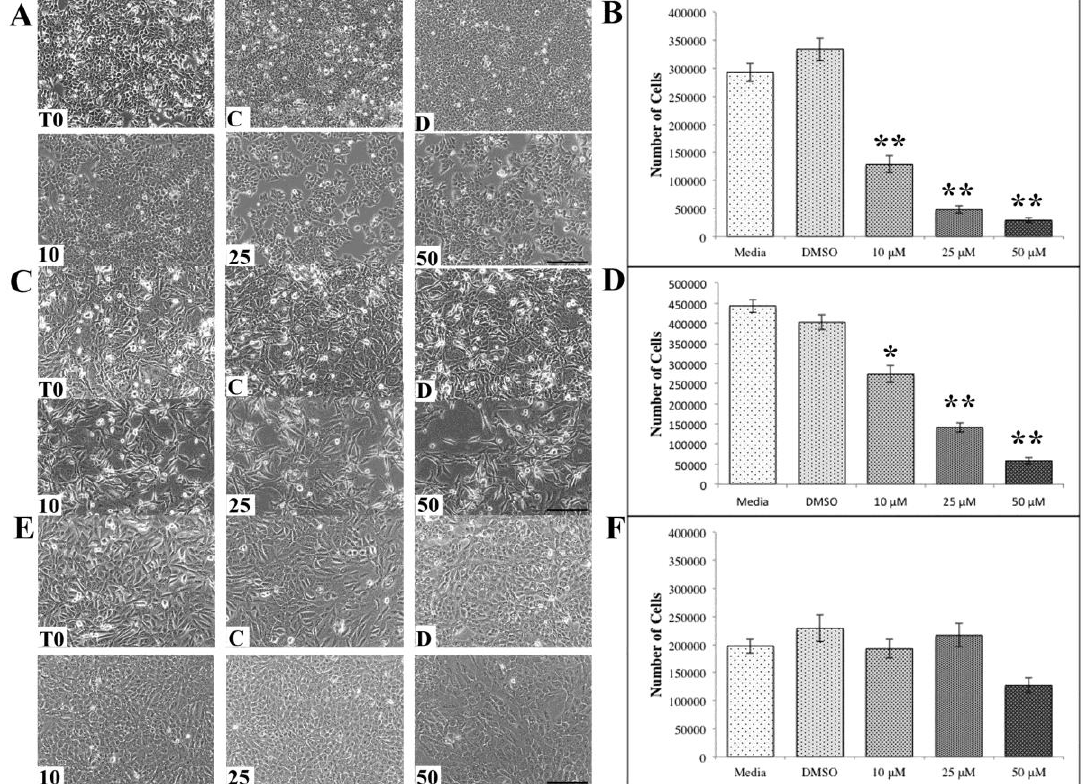
Figure 3. Astaxanthin (ASX) affects cell numbers. ( A ) MCF7 cells treated with ASX at concentrations indicated for 24 h; ( B ) quantification of ( A ); ( C ) MDA-MB-231 cells treated with ASX; ( D ) quantification of ( C ); and ( E ) MCF10A cells treated with ASX at concentrations indicated for 24 h and quantified in ( F ). (T0-time zero, C-untreated, D-DMSO, 10 µ M, 25 µ M, 50 µ M). Scale bars = 100 µ m. * p < 0.05, ** p < 0.01.